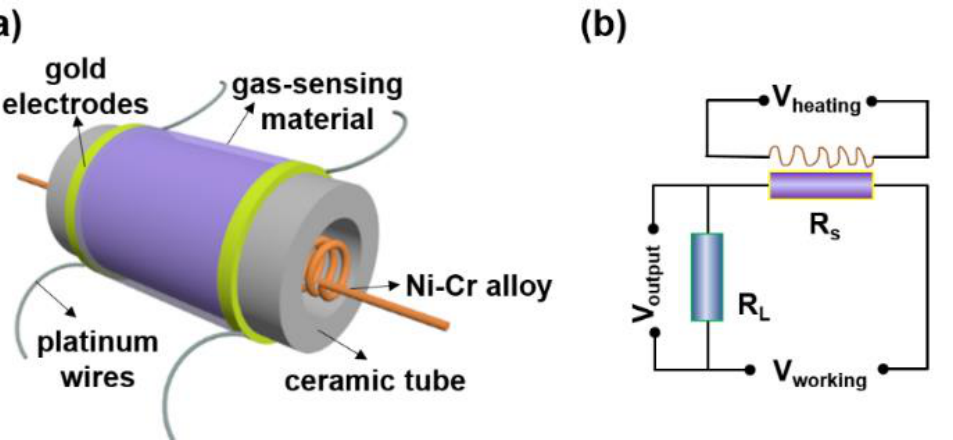
Figure 1. ( a ) The diagrammatic sketch of side-heated gas sensor. ( b ) The electric circuit of thegas sensing